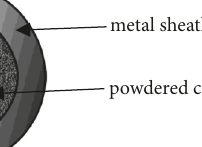
Table 1: Chemical composition of REE-Si-Fe (wt. %).